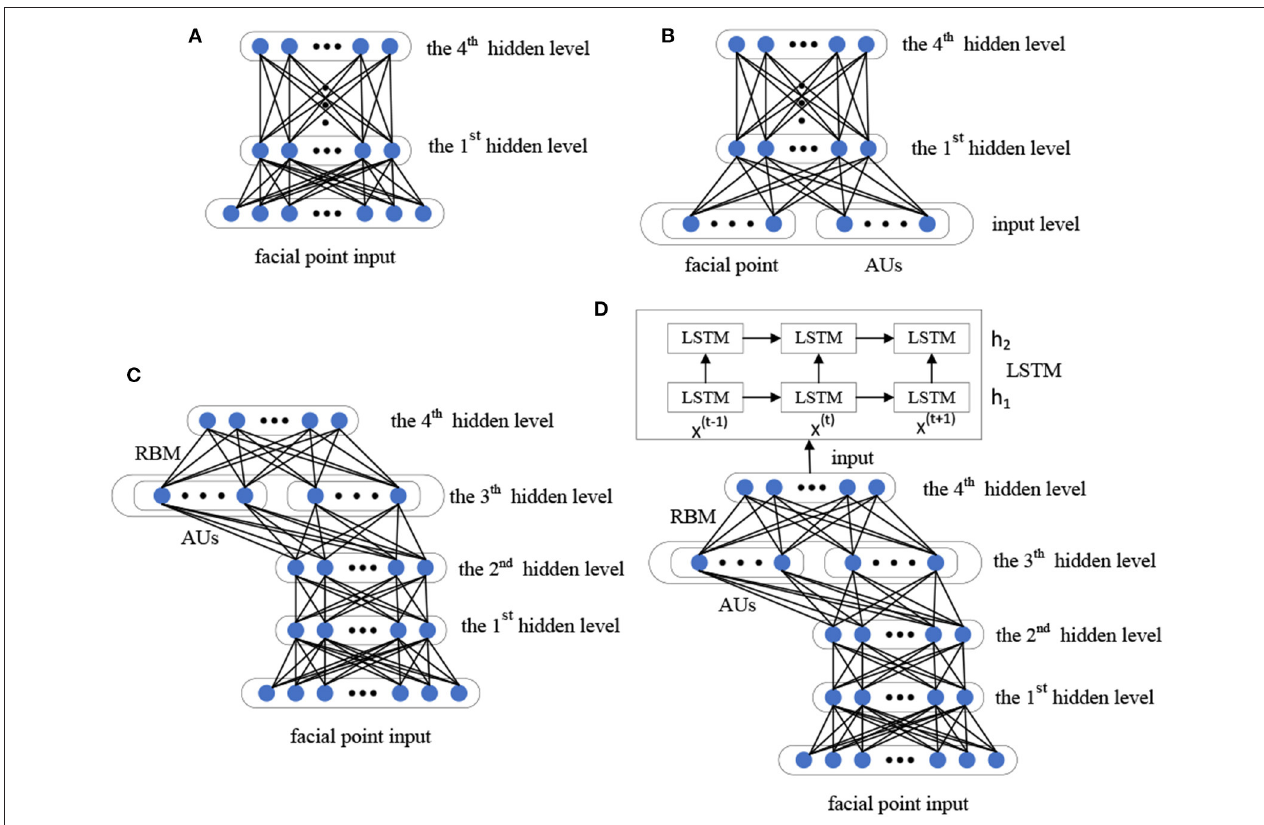
FIGURE 5 | Framework of four different deep belief network (DBN) models: (A) 4DBN, (B) 4DBN-AU, (C) AU-4DBN, (D)